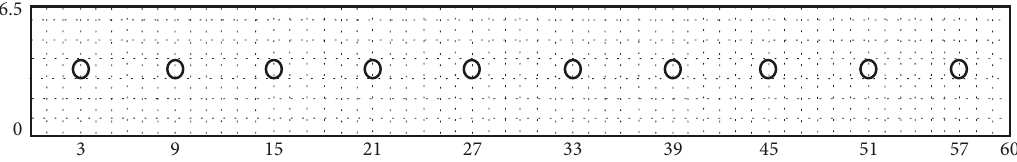
Figure 9: Arrangement of monitoring points on the platform plane.